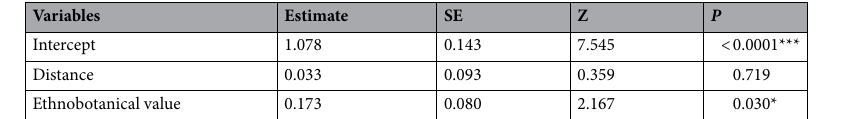
Table 4. Generalized linear model with negative binomial errors testing the effects of the distance between agroforestry systems and their surrounding vegetation and ethnobotanical value on agroforestry systems species